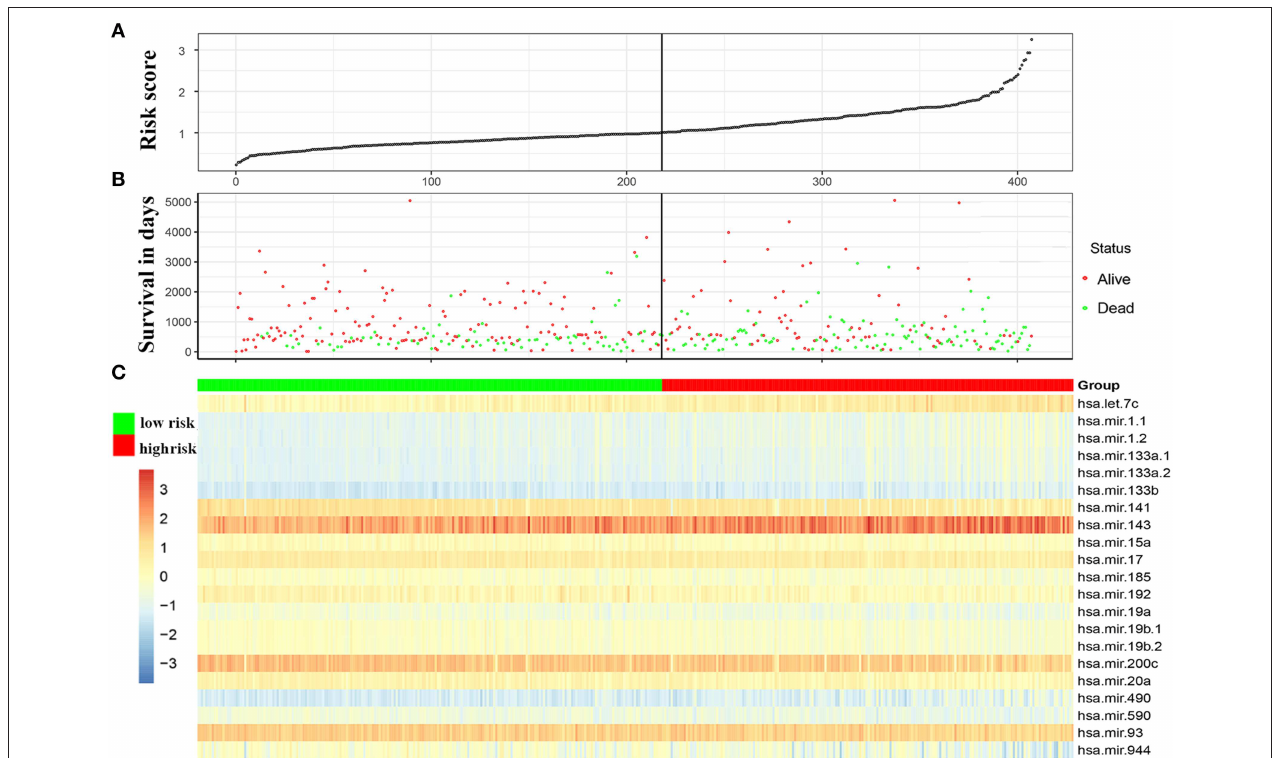
FIGURE 1 | Characteristics of the 21-miRNA signature based signature. (A) The distribution of the 21-miRNA signature risk score for each patient. (B) The overall survivals of patients with bladder cancer, and their survival status. (C) Centered and scaled expression level of the 21 miRNAs in the signature in low-risk group and high-risk group, with cold color representing low expression and warm color representing high